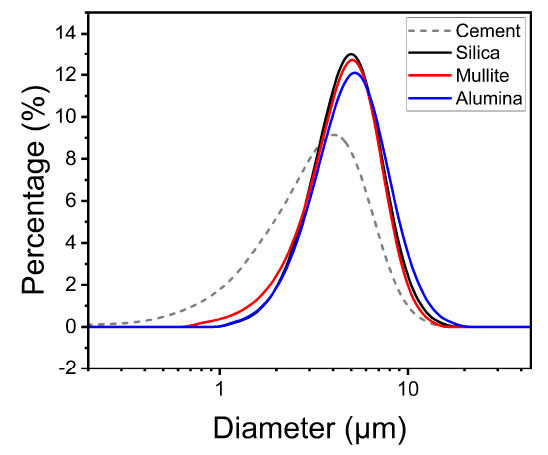
Figure 1. Particle size distribution of component materials.